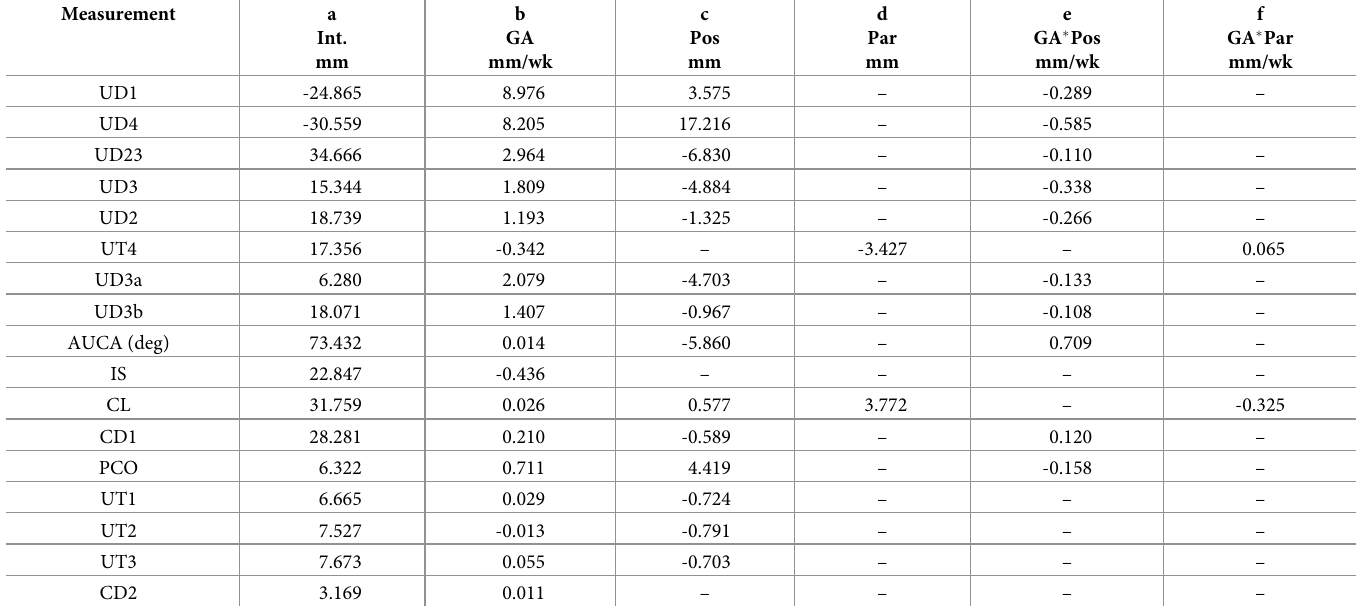
Table 3. Summary of linear mixed model fixed effect coefficients from Eq 1 sorted by highest to lowest ICC value (non-significant terms are dropped with coeffi- cients indicated as –). The line indicates the cutoff between good and fair, as prescribed in the methods section. Measurements are based on ICC values in Table 2. Int. = intercept.